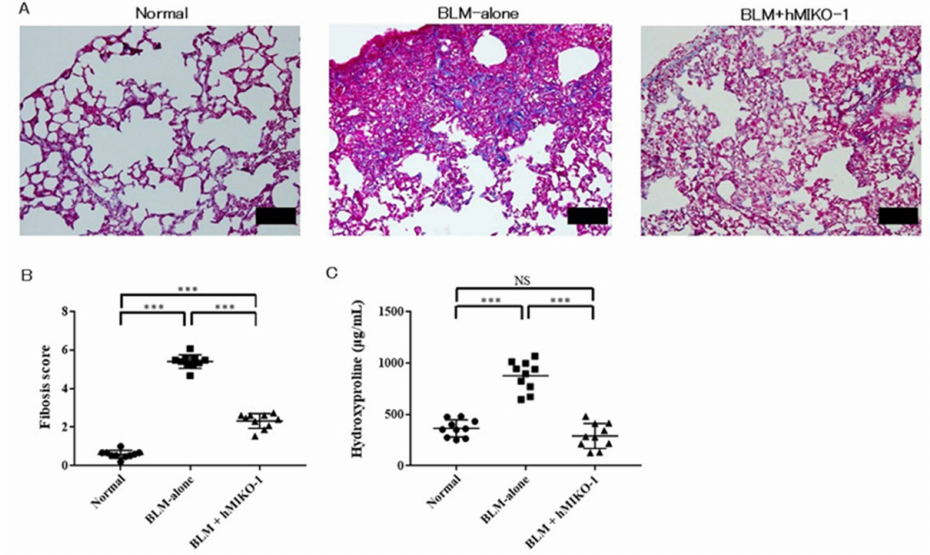
Figure 1. Human MIKO-1 reduces lung fibrosis in the lungs of mice 28 days after bleomycin administration. ( A ) Collagen deposition areas. Scale bars: 100 mm. ( B ) Fibrosis scores. ( C ) Collagen contents. Data are shown as mean ± SD (N = 10 mice per group). *** p < 0.001, significant differences between the linked groups. NS: not